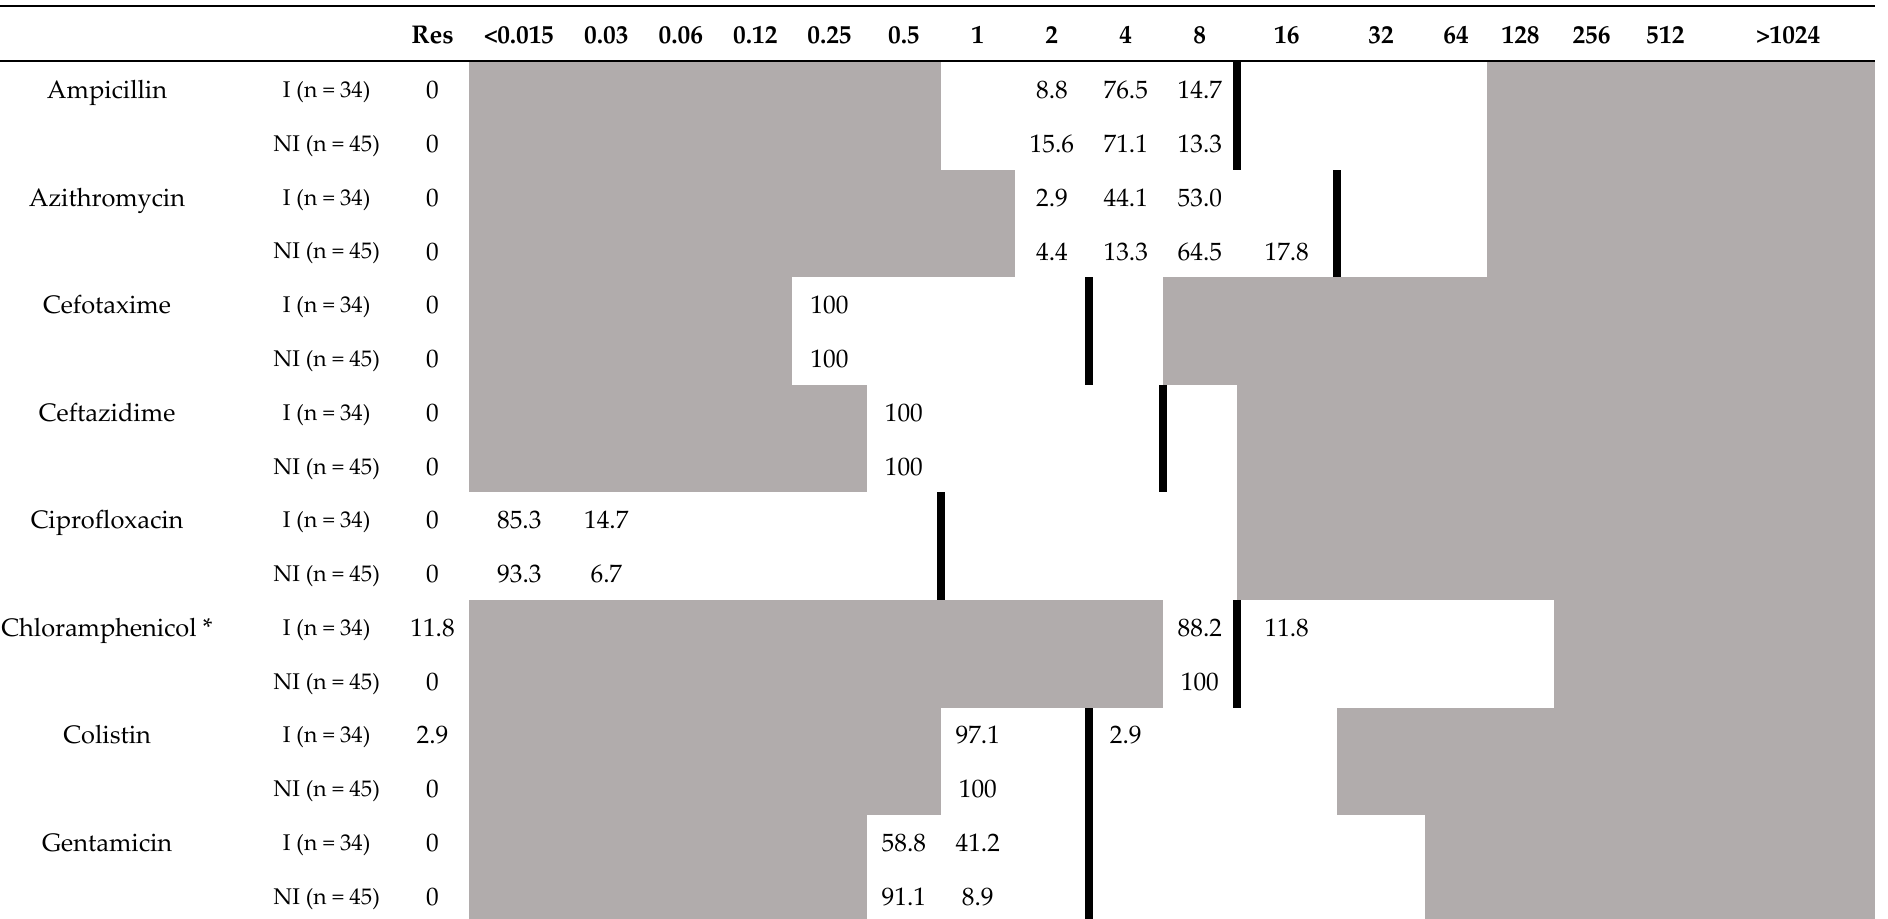
Table 2. Distribution of MICs (mg/L) and resistance of the 79 isolates of Escherichia coli from the cranial vagina of seven inseminated (I) and five non-inseminated (NI) mares. The results are shown as the percentage of isolates at different MIC values.